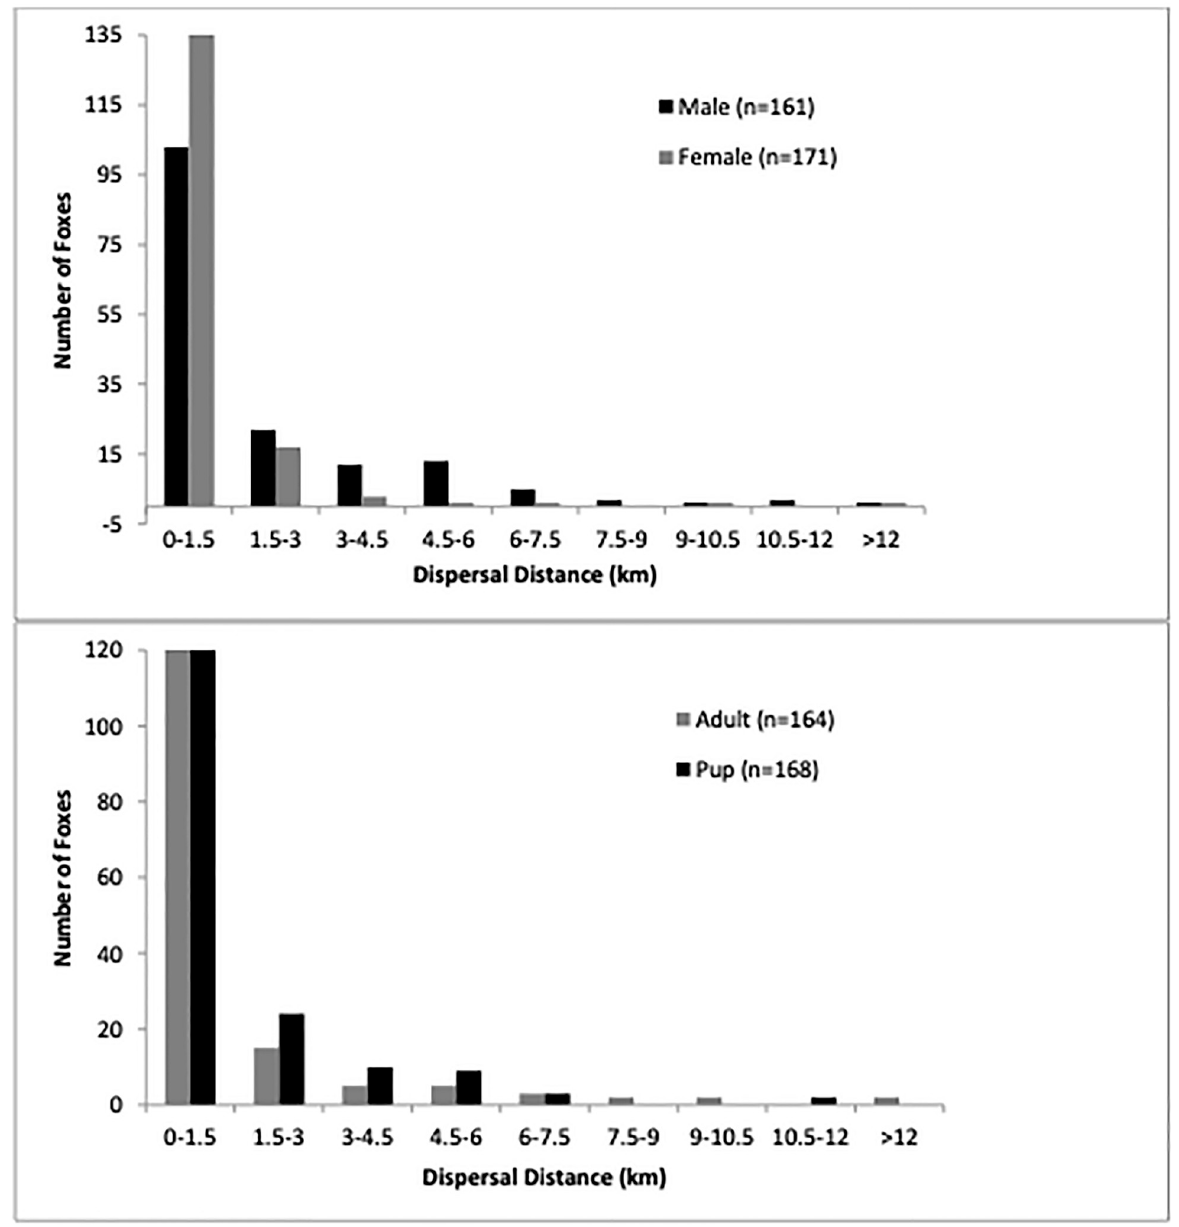
Fig 3. Summary of distances moved by San Joaquin kit foxes in Bakersfield, California, inferred from re-trapping or found carcasses.